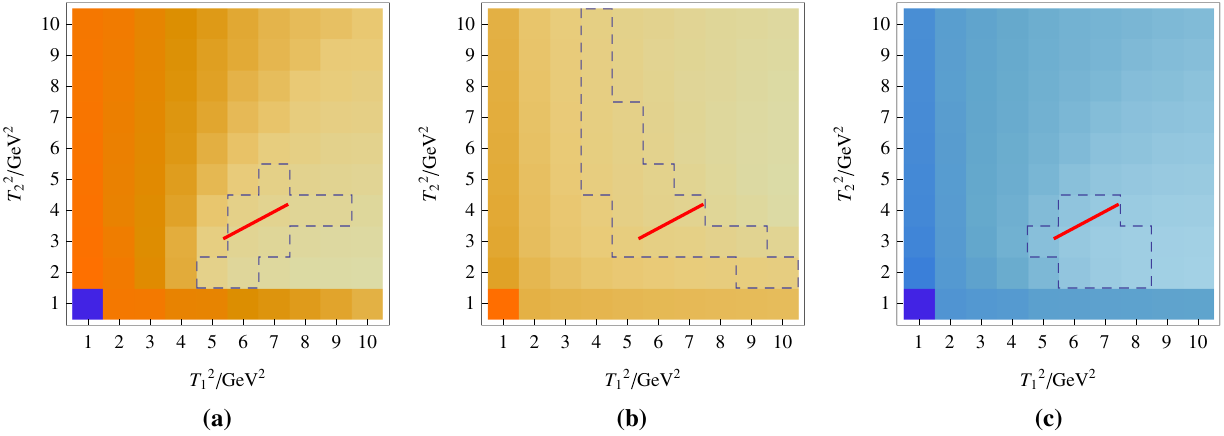
Fig. 8 F 1 , 2 , 3 at q 2 = 0 as functions of the Borel parameters T 2 T 2 in the process of (cid:2) ++ cc → (cid:6) + c , where T 2 2 parameters. Positive and negative values are, respectively, displayed as reddish ( F 1 , 2 ) and bluish ( F 3 ), and the greater the absolute value for the formfactors F i ( 0 ) , the darker the color. The allowed Borel regions are